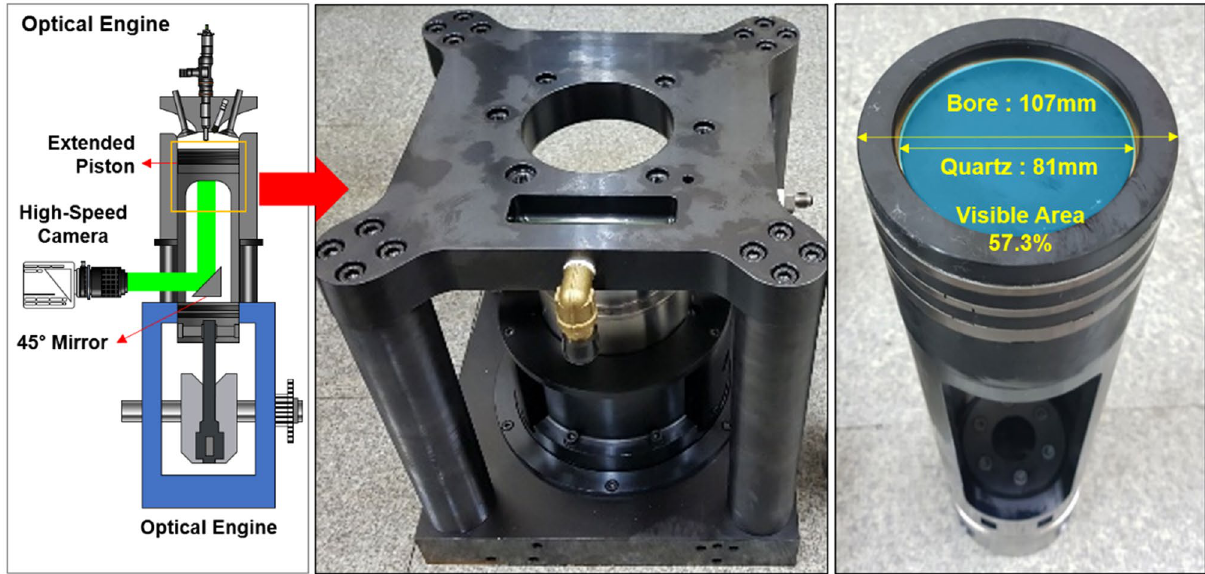
Figure 2. Schematic diagram of experimental optical engine.